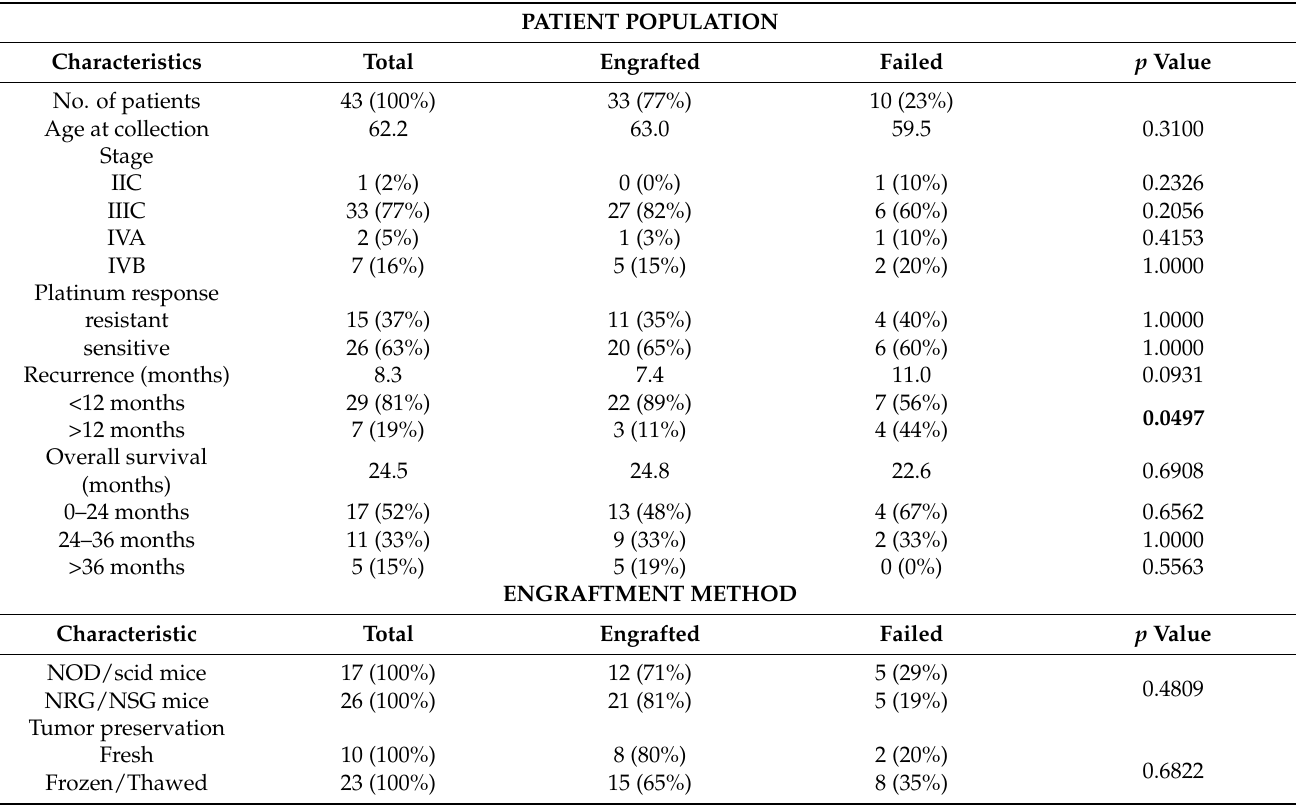
Table 1. Patient characteristics and PDX engraftment